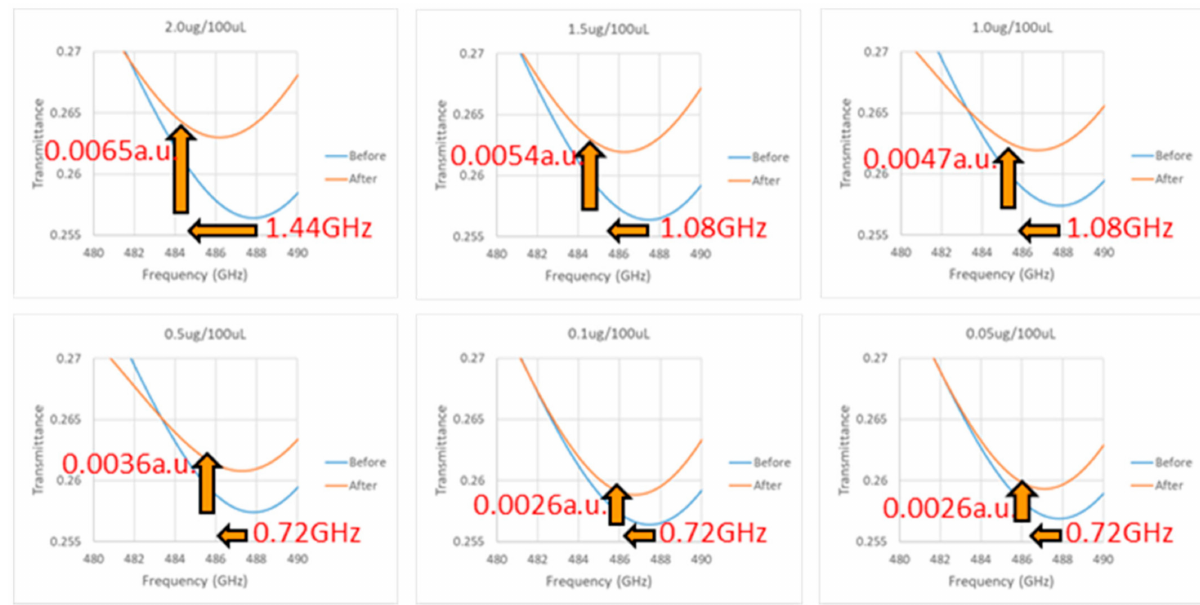
Figure 9. Resonance curve of troponin antigen experiment by VDI system. On the average shift of the x -axis ( ∆ X), the concentration of 0.00~0.5 µ g/100 µ L has a 0.72 GHz shift, 1.0~1.5 µ g/100 µ L has a 1.08 GHz shift, and 2.0 µ g/100 µ L has a 1.44 GHz shift. On the y -axis average variation ( ∆ Y), the variation demonstrates 0.0026, 0.0026, 0.0026, 0.0036, 0.0047, 0.0054, and 0.0065 a.u. changes from low to high concentra- tions. Figure 10 shows the relationship between the concentration of antigen and ∆ X, ∆ Y. The minimum concentration that can be detected by the chip in the VDI system is between 0.1~0.5 µ g/100 µ L, and the concentration and ∆ Y show a positive correlation of R 2 =